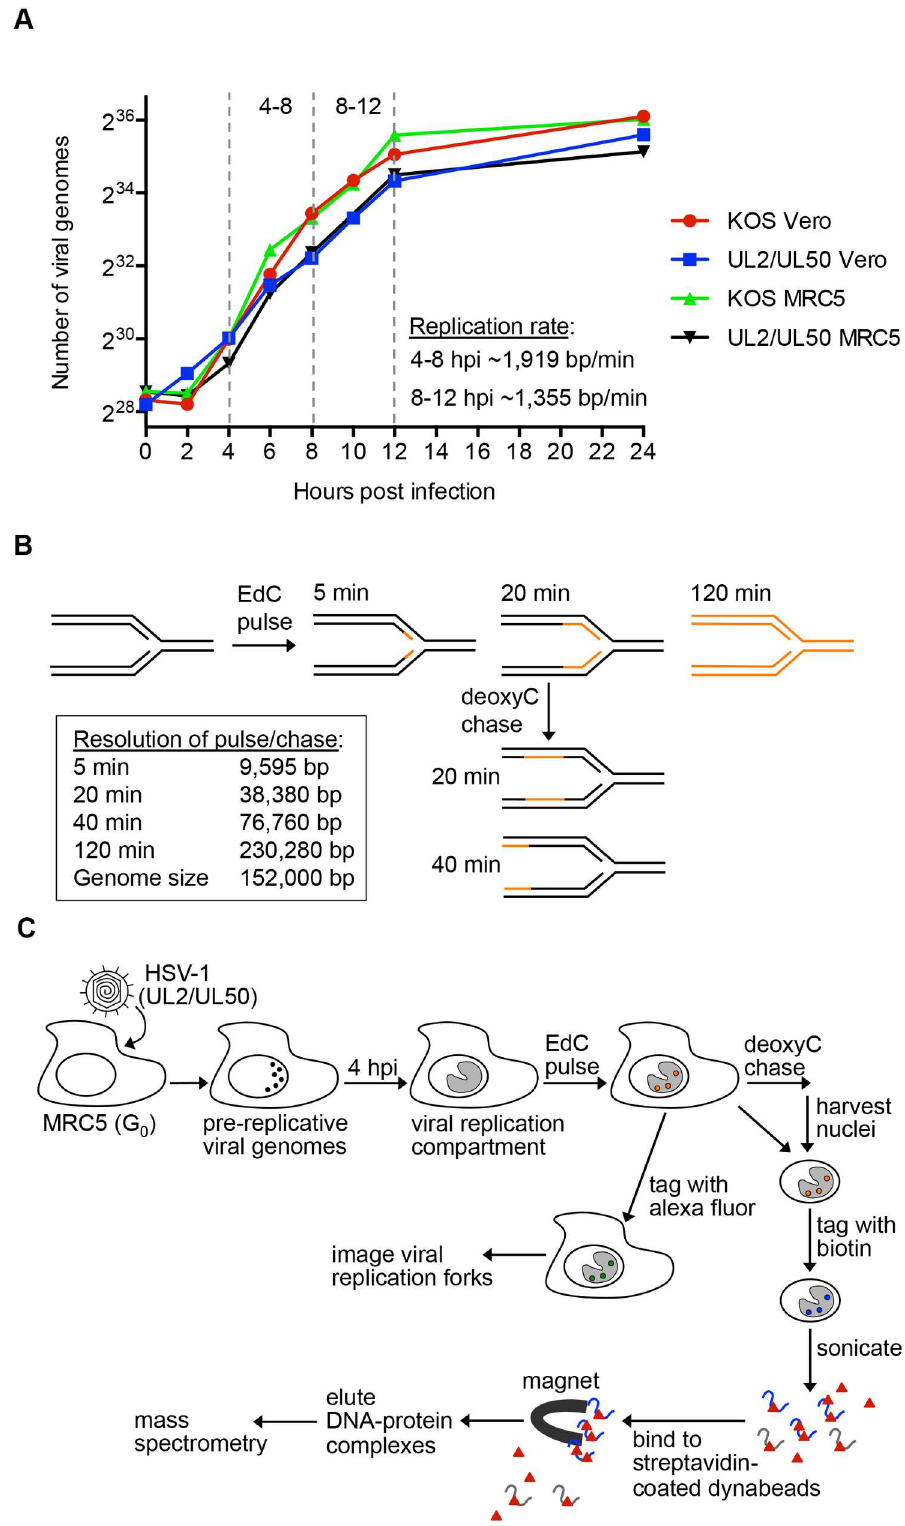
Fig 1. Methodology to Label, Image, and Purify HSV-1 Replication Forks. A. Calculationof the rate of viral DNA replication. MRC5 or Vero cells were infected with KOS or UL2/UL50 and the number of